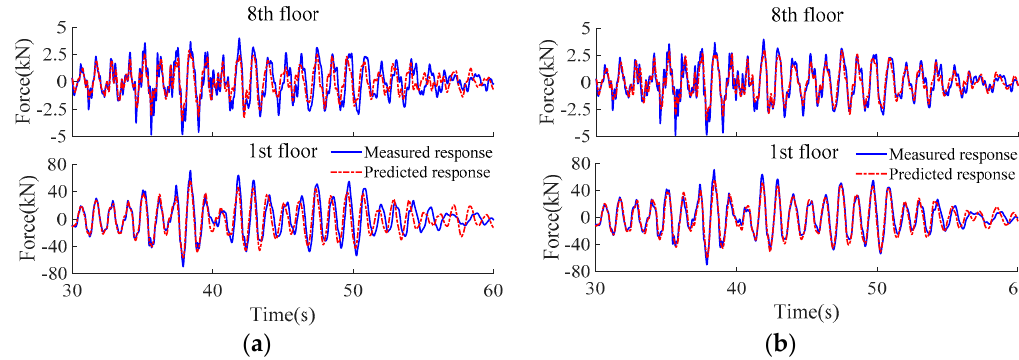
Figure 9. Comparison of the predicted and measured damper force: ( a ) updated model I; ( b ) updated model II. Table 5. Normalized root mean squared errors (NRMSEs) of the response predictions of updated models.